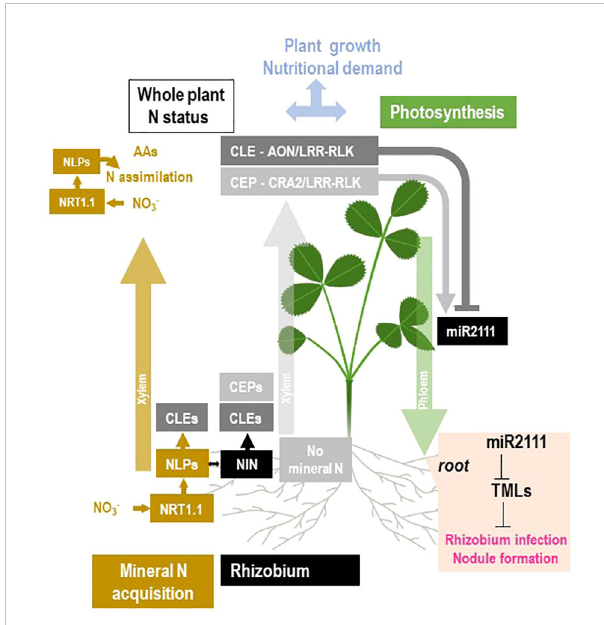
FIGURE 9 Schematic overview of the current knowledge of the molecular mechanisms potentially involved in the systemic regulation of nodule formation by the plant N status. The general framework of the fi gure is described in Figure 2. These mechanisms were initially related to the plant response to NO 3 − (NRT1.1/NLPs module; in brown) or to the systemic control of nodule formation by the plant (CLE-AON/LRR-RLK and CEP-CRA2/LRR-RLK modules; respectively in dark and light gray). The mechanism related to the NO 3 − response and to NO 3 − assimilation is in brown. NO 3 − fuels N assimilation and the production of amino acids. It also activates, through the action of the NO 3 − transceptor NRT1.1 (NPF6.3/CHL1) and NLP transcription factors (MtNLP1 and LjNRSYM1), the accumulation of NO 3 − -responsive CLE peptides (MtCLE35, LjCLE-RS2, LjCLE-RS2, and Gm NIC1), as well as the genes encoding the enzyme of NO 3 − assimilation (including NR and NiR). Rhizobium interaction triggers the accumulation of the NIN transcription factor, also related to NLP family, involved in the activation of CLE peptides in response to rhizobium (MtCLE12, MtCLE13). CLE peptides may be transported from the roots to the shoots through the xylem fl ow. In the shoots, the CLE peptide activation of AON/LRR-RLK receptors (MtSUNN, LjHAR1 forming possibly heterodimers with MtCLV2 and MtCRN or LjCLV2, and LjKLV) results in the downregulation of the level of miR2111 circulating in the phloem between shoot and roots. In the absence of mineral nitrogen, CEP peptides accumulate in the roots (MtCEP1 and MtCEP7) and are translocated to the shoot by the xylem. In the shoots, the CEP peptide activation of the CRA2/LRR- RLK receptor stimulates the miR2111 levels, antagonistically regulated by CLE-AON/LRR-RLK and CEP-CRA2/LRR-RLK pathways. In the roots, the miR2111 inhibits TML (by mRNA cleavage) that is actively repressing nodule formation. Consequently, CLE-AON/LRR- RLK and CEP-CRA2/LRR-RLK pathways respectively inhibits or promotes nodule